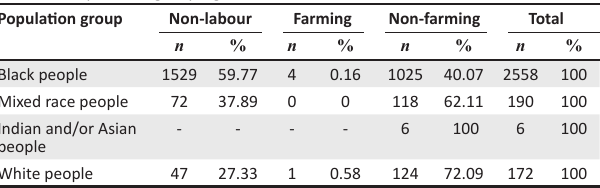
TABLE 4: Population grouping. Population group Non-labour Black people Mixed race people Indian and/or Asian people